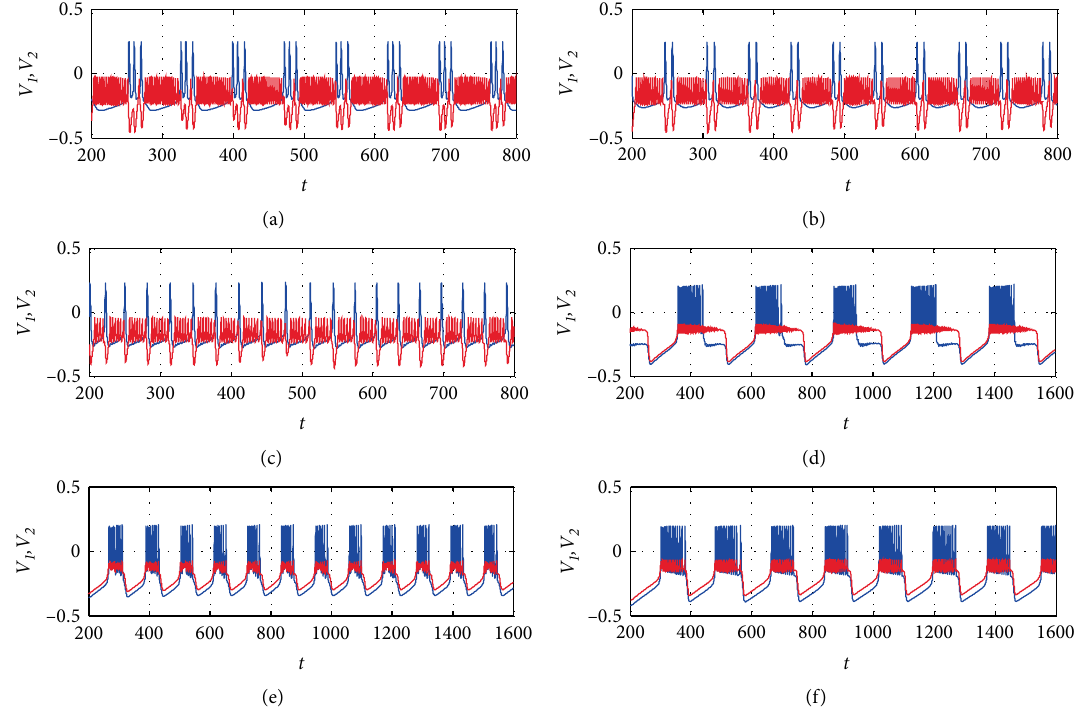
Figure 10: Synchronization transition of two nonidentical coupled neurons with different coupling intensity values. (a) 𝑔 (c) 𝑔 , (d) 𝑔 , (e) 𝑔 , and (f) 𝑔 . Initial conditions are selected as (−0.1, 0, −2.5) and (−0.2, 0, −2.5) , 𝑠 = 0.15 𝑠 = 0.5 𝑠 = 0.7 𝑠 = 0.9